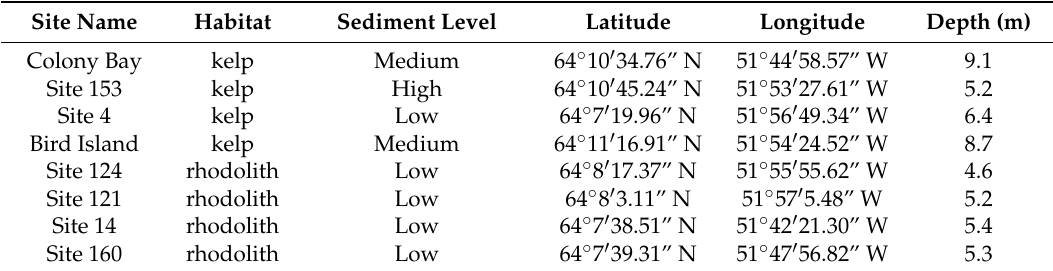
Table 1. Descriptive information of all dive sites including habitat type, qualitative assessment of sedimentation level (high, medium, and low), GPS coordinates (degrees minutes seconds), and average depth of site at slack tide